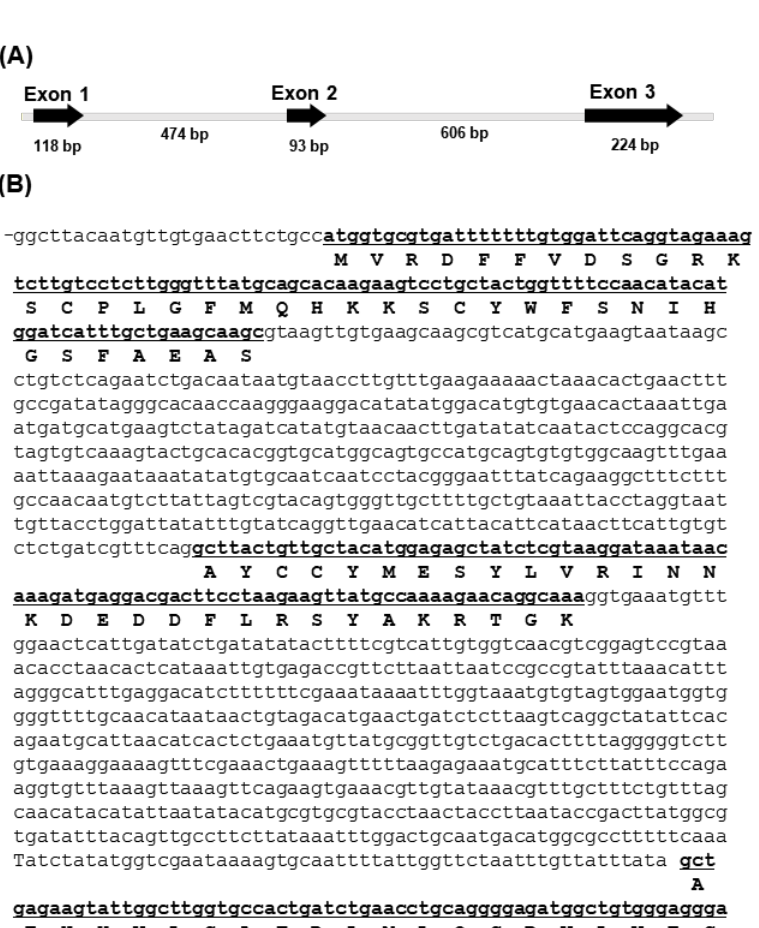
Figure 1. Structure and sequence of a gene encoding a C-type lectin domain-containing protein (CTLD) from Pacific abalone ( AbCTLD ). ( A ) The gene encoding AbCTLD consists of three exons (underlined) with lengths of 118 bp, 93 bp, and 224 bp. ( B ) The coding regions, corresponding amino acids, and polyadenylation signal (aataaa) are shown in bold.